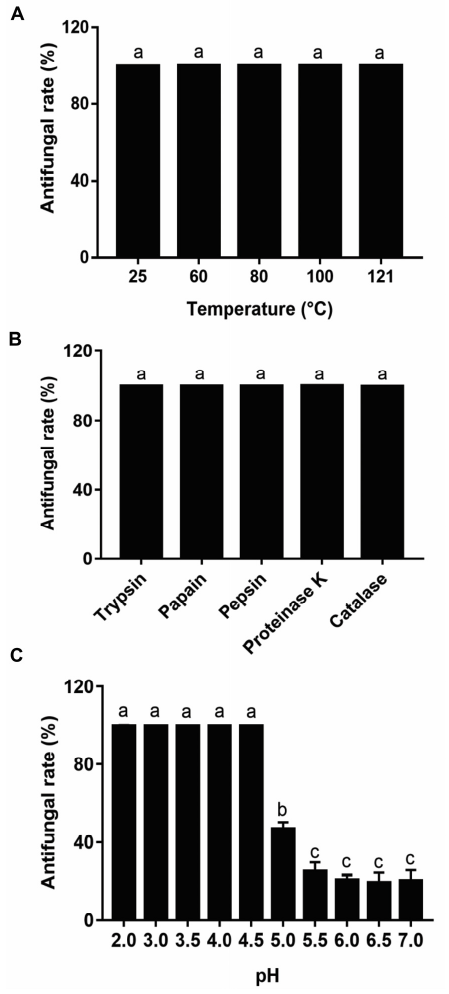
Figure 4. Antifungal activity stability of metabolites produced by the Lactiplantibacillus plantarum LPP703 strain. ( A ) Antifungal activity of heat-treated metabolites against Penicillium sp. ( B ) Anti- fungal activity of protease-treated metabolites against Penicillium sp. ( C ) Antifungal activity of metabolites after pH change against Penicillium sp. The one-way analysis of variance followed by